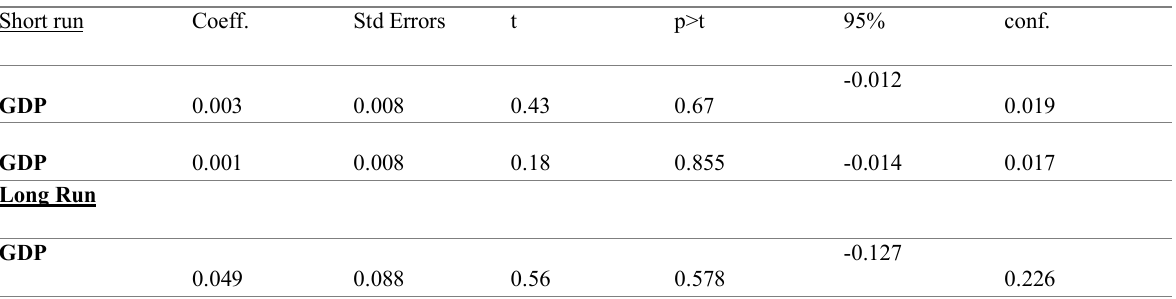
Table 9: Regression results for GDP growth rate and capital flight